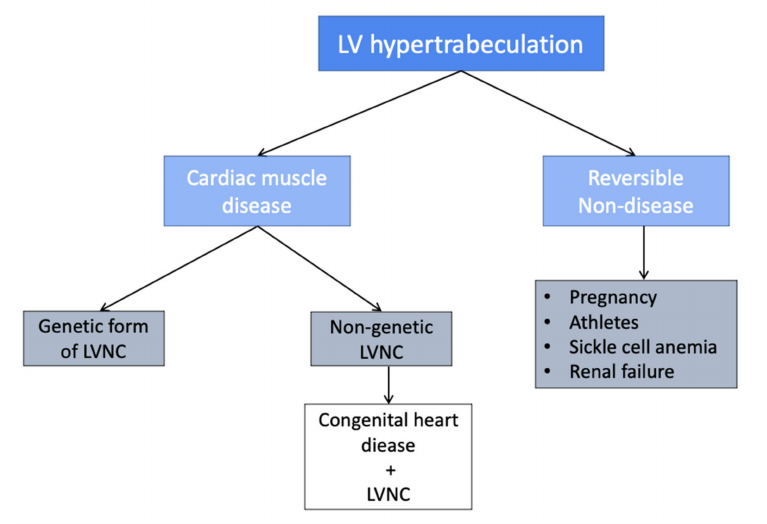
Figure 1. LV hypertrabeculation